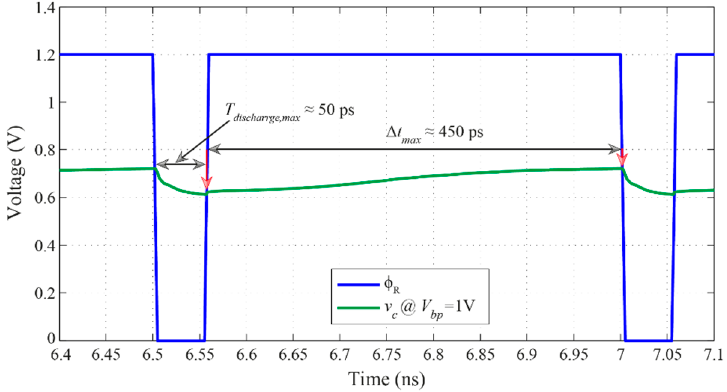
Figure 9. Voltage across the loop filter’s capacitor v c and reset signal ϕ R at locked state.